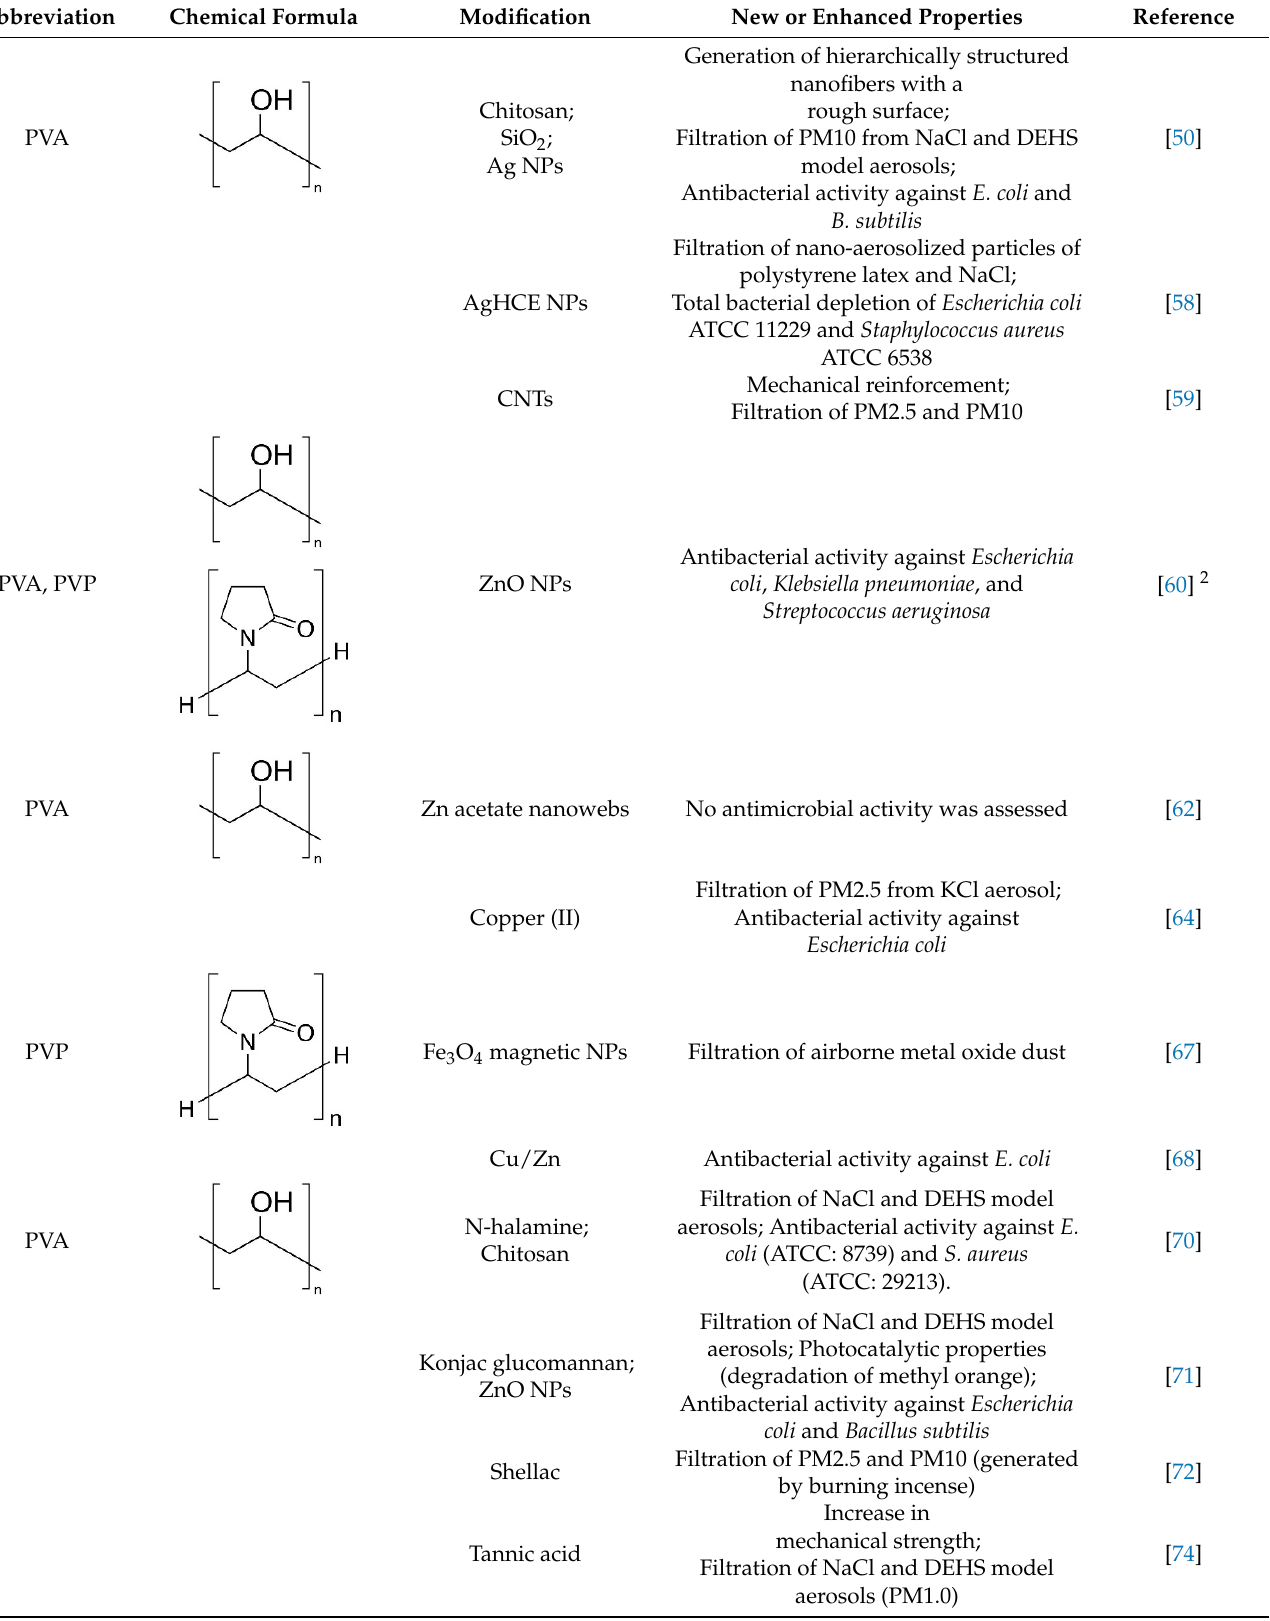
Table 1. Electrospun water-soluble synthetic polymers.